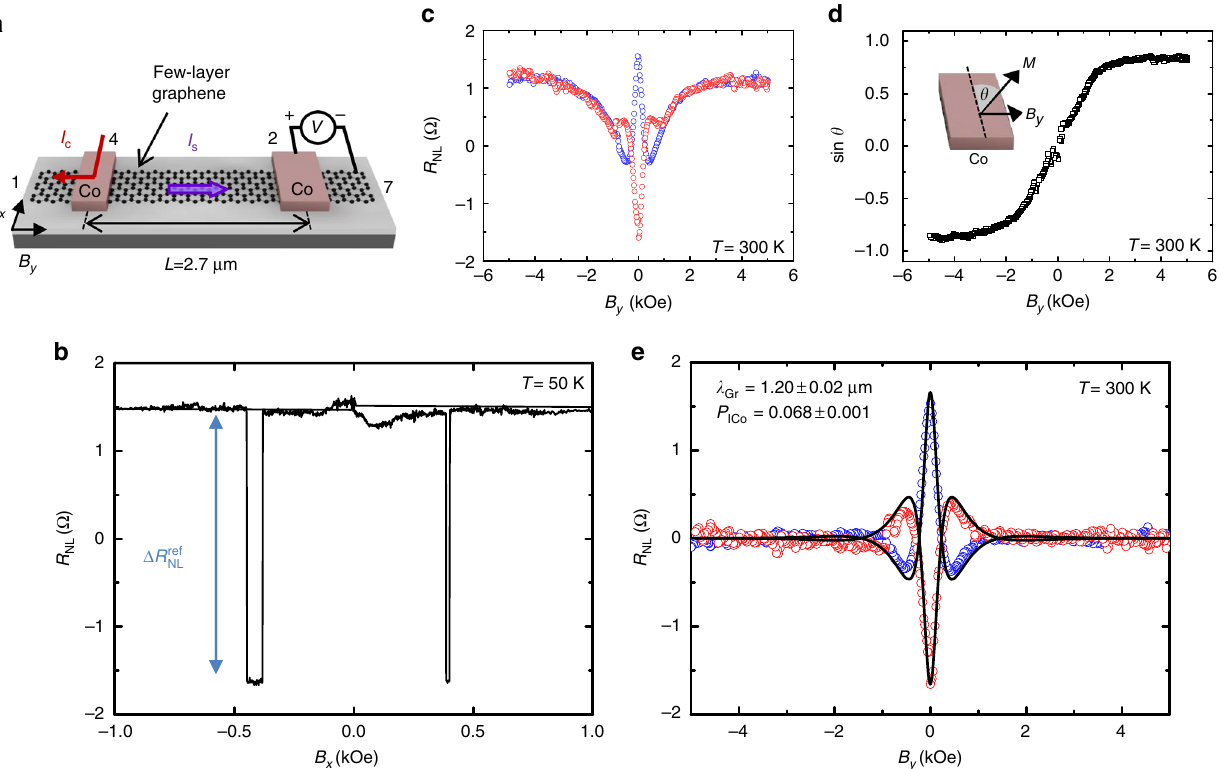
Fig. 2 Spin transport in a reference trilayer graphene lateral spin valve. a Sketch of the measurement con fi guration, including the electrodes from Fig. 1b that are used, and the directions of the applied magnetic fi eld ( B x and B y ). b Non local resistance as a function of B x measured with I C = 10 μ A at 50 K and center-to-center Co electrode spacing L = 2.7 μ m in the con fi guration shown in a . R NL switches between high and low resistance states for parallel and antiparallel magnetization orientation of the Co electrodes while sweeping B x . The reference spin signal ( Δ R ref ) is tagged. No baseline signal has been NL subtracted. c Hanle measurement, for which R NL is measured in the same device as a function of B y with I C = 10 μ A at 300 K in the con fi guration shown in a while the injecting and detecting Co electrodes are in the parallel ( blue ) and antiparallel ( red ) magnetization con fi gurations. d sin θ as a function of B y extracted from data in c . Inset: the magnetization direction of the Co electrode relative to x direction de fi nes the angle θ . e Pure spin precession and decoherence data extracted from data in c , where the contribution from the in-plane magnetization rotation of the electrodes under B y is removed. Spin transport properties are extracted by fi tting the Hanle equation to the experimental data ( black solid lines , see Supplementary Note